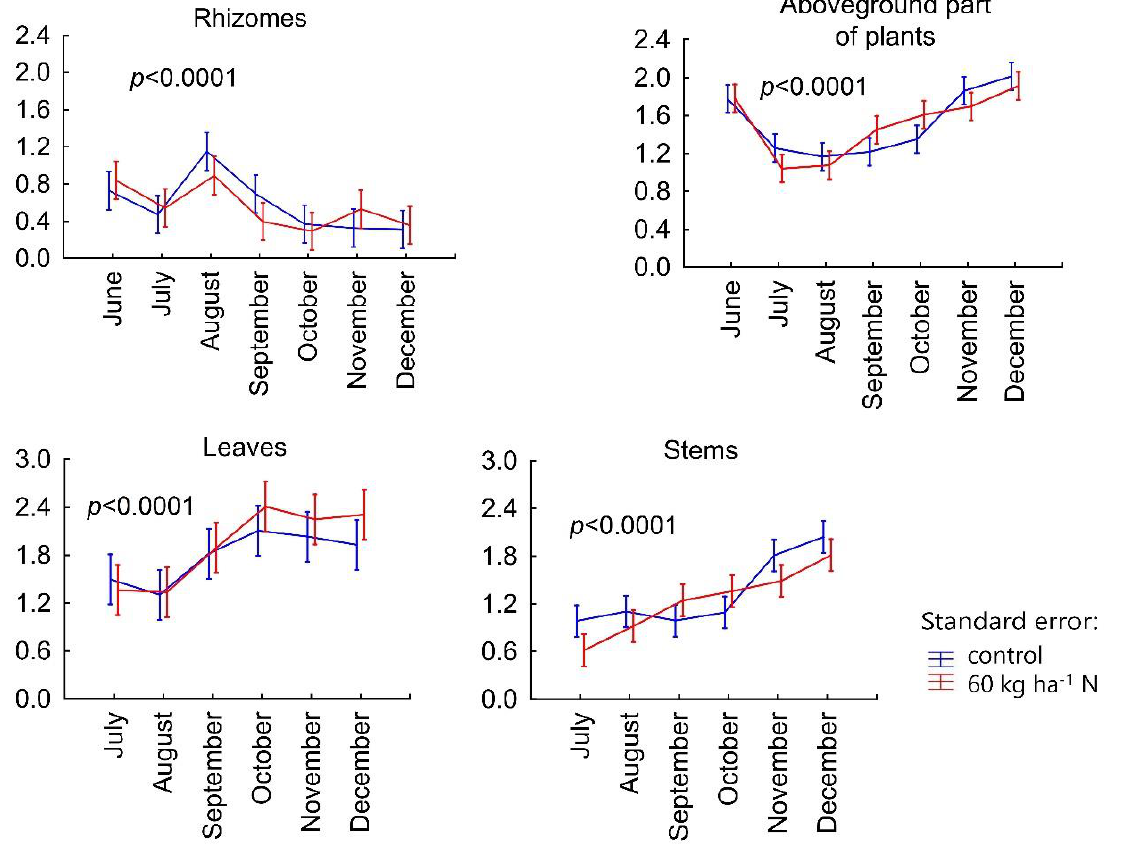
Figure 6. Calcium content in examined part of miscanthus (g kg − 1 ) (three-year average content from measurements during the growing season every 30 days).